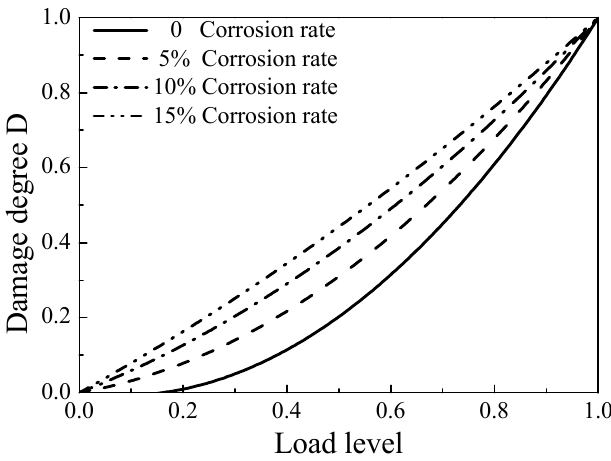
Figure 9. Correlation curve of the load and damage degree.